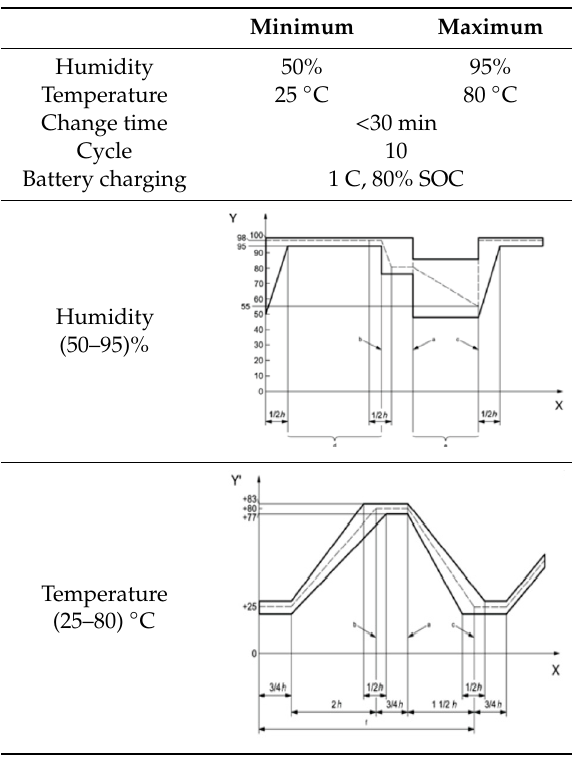
Table 7. Test profile for thermal shock of Lithium-ion battery.